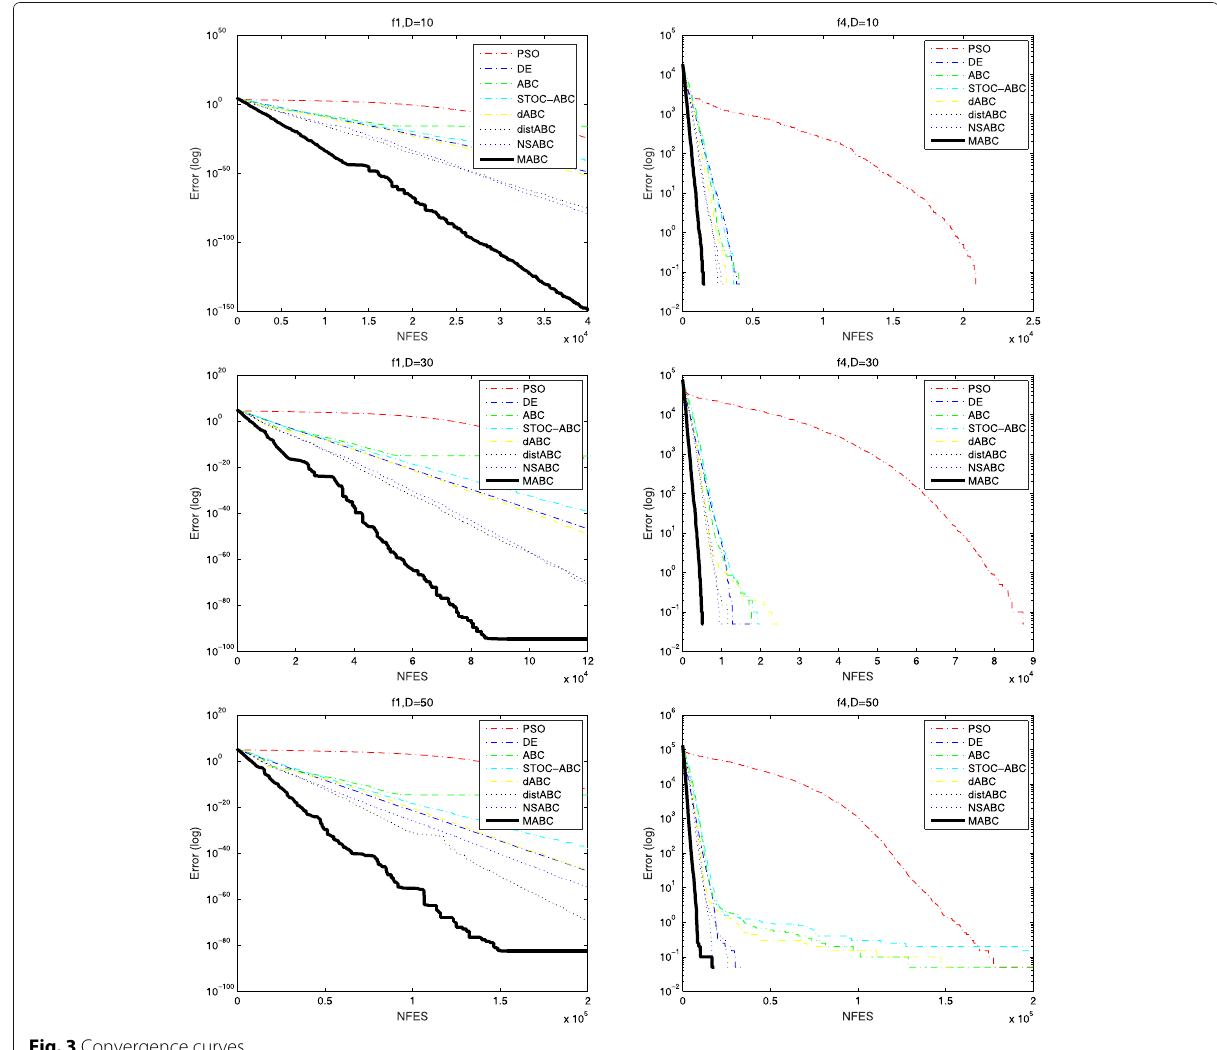
Fig. 3 Convergence curves